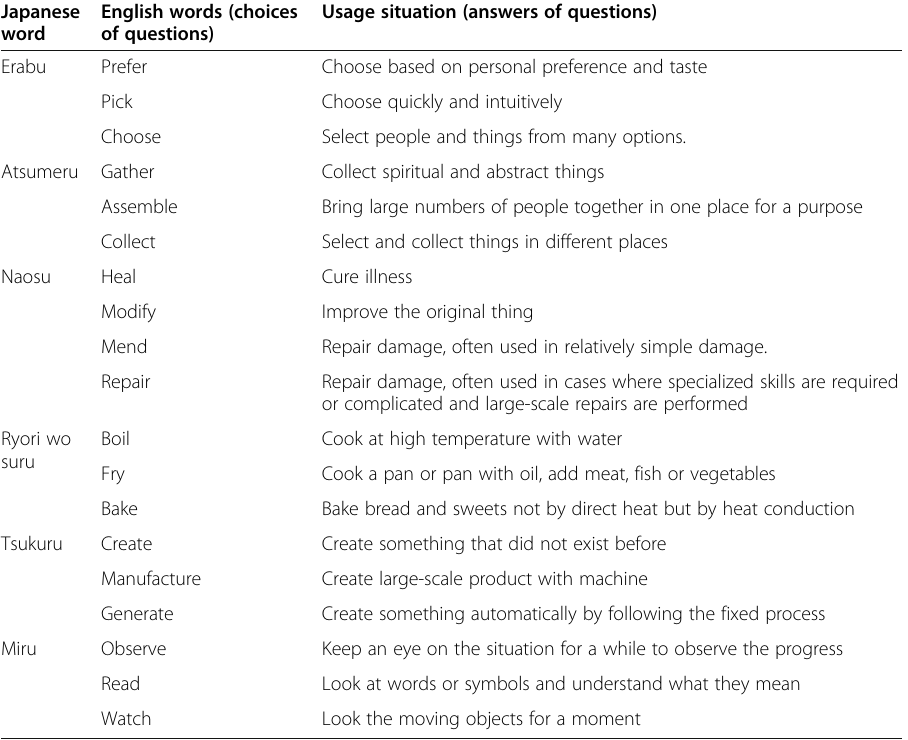
Table 2 English words used in the pre-test, their Japanese translation, and their usage situation Japanese